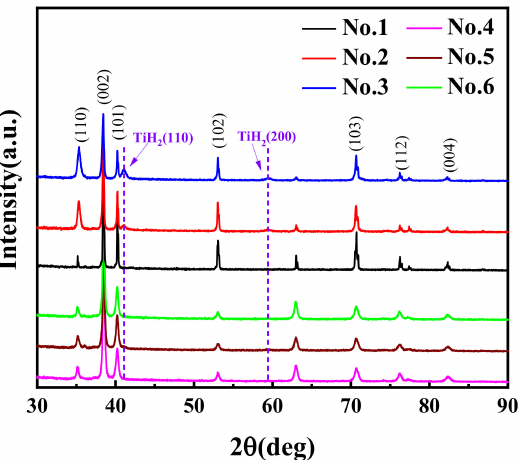
Figure 1. XRD spectra of pure titanium samples before and after electrolytic hydrogen charging under different annealing